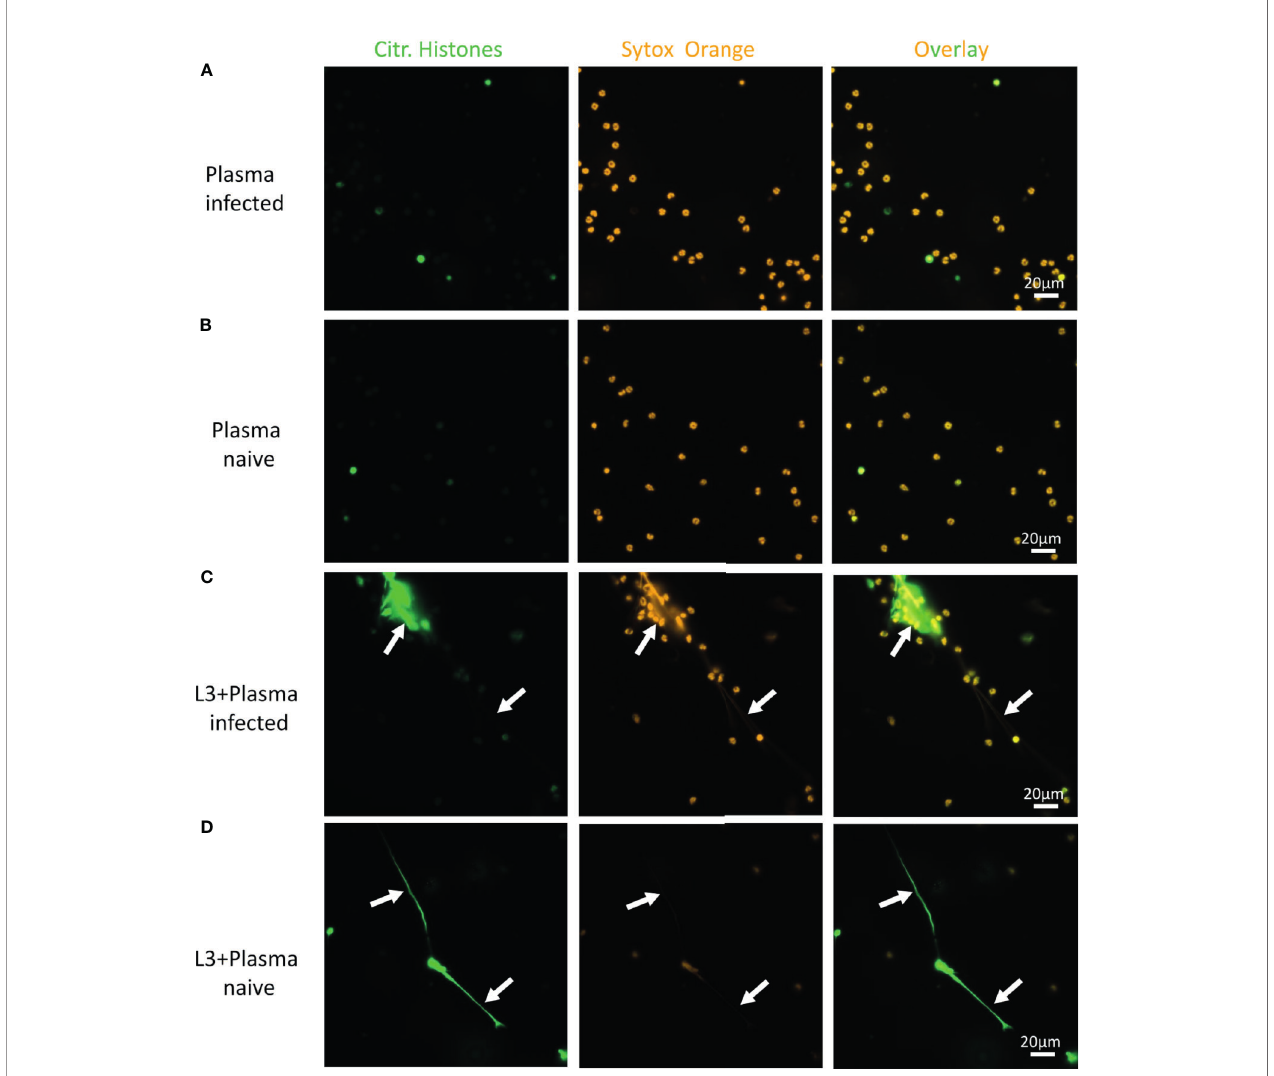
FIGURE 5 | L3-triggered NETosis is enhanced by plasma from infected animals. Representative fl uorescence microscopy pictures of neutrophils stimulated with plasma from S. ratti infected animals (A) , plasma from naive animals (B) , S. ratti L3 larvae and plasma from S. ratti infected animals (C) or L3 larvae and plasma from naive animals (D) . Cells were stained for citrullinated histones (green, left pannel) and for DNA with Sytox orange (orange, middle pannel), right pannel shows the overlay. Shown are the results from one out of two independent experiment with n =